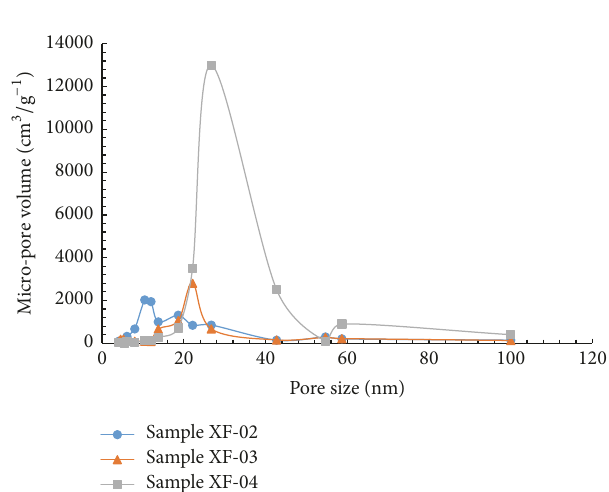
Figure 3: The BJH distribution of pore size of the rock salt samples.